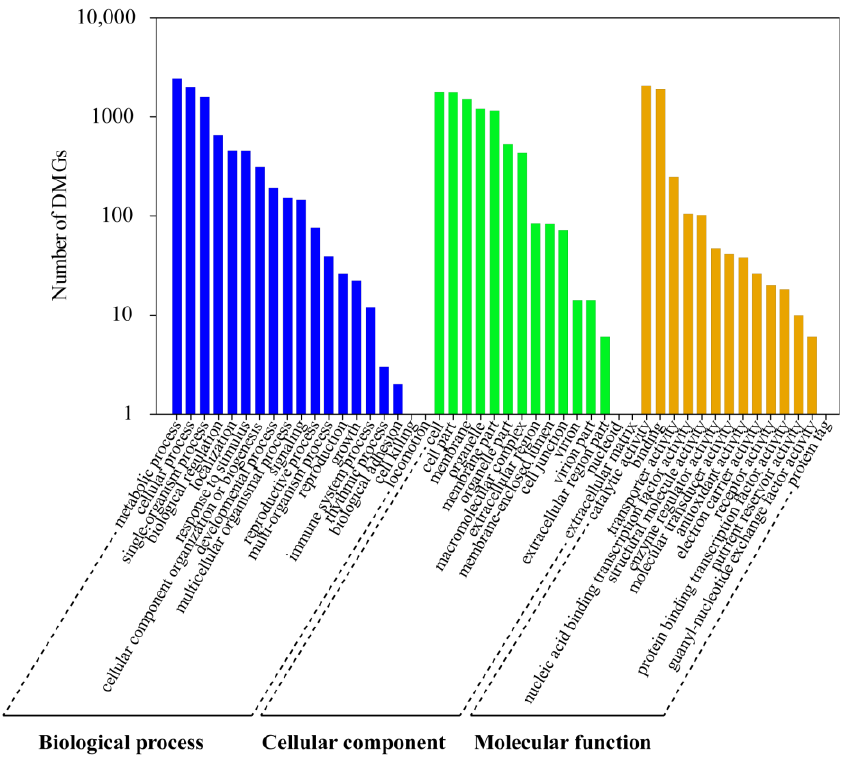
Figure 7. Gene Ontology (GO) annotation of differentially methylated region (DMR)-related genes (DMGs) in CHH type (H =A, T, or C) in SV and PV grafts (SV: grafts with strong growth vigor; PV: grafts with poor growth vigor).